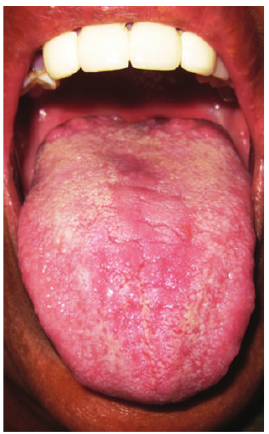
Figure 1: Central longitudinal and coated tongue.